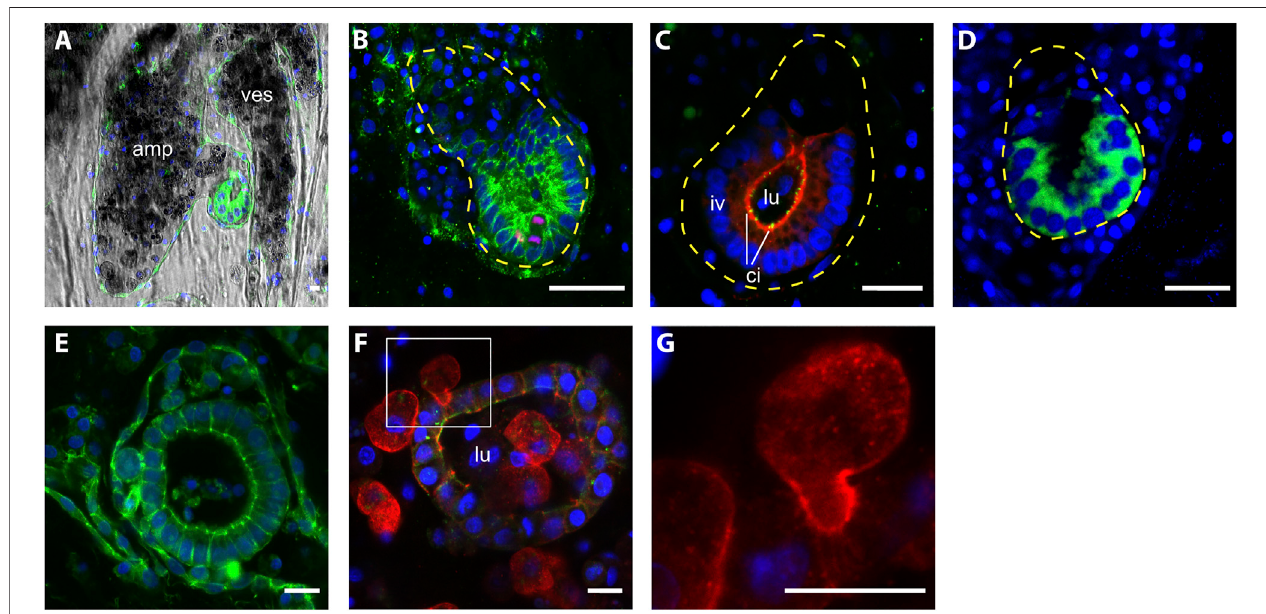
FIGURE 4 | Morphology of intravascular double vesicles.1 (A) The putative vascular bud grows in the protrusion of an ampulla and (B) it closely interacts with the vascular epithelia, the cells in contact with the vascular epithelia are thicker than the most distal cells. Cell shape is labeled with anti-tyrosinated tubulin (green) and proliferating cells are labeled with anti phospho HH3 (red). (C) Anti-PKC ξ (red) shows the apicobasal cell polarity and anti-gamma tubulin (green) shows the presence of cilia. (D) The polarization of the intravascular vesicle is also highlighted by the transient localization of Wnt2 (green). (E – F) Bigger vesicle within the lumen mesenchymalcells,anti-tyrosinatedtubulin(green),anti-pan-tyrosinekinase(red). (G) Detailsofamesenchymalcellinteractingwiththeepitheliaofthevesicle.Cellnuclei are counterstained with Hoescht (blue). Amp, ampullae; ves, vessel; lu, lumen; iv, inner vesicle; ci, cilia. Scale bar, 10 μ .